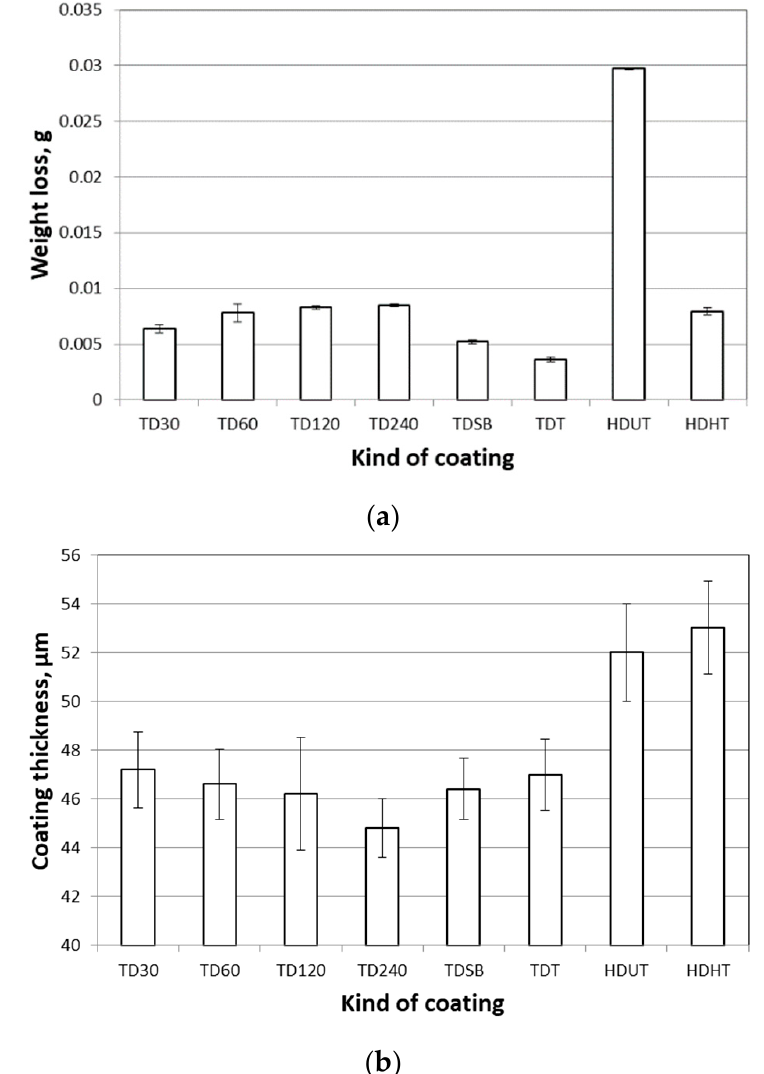
Figure 7. The disc-shaped samples’ weight loss after the pin-on-disc friction test ( a ) and comparison of the thickness of the TD and HD zinc coatings ( b ).